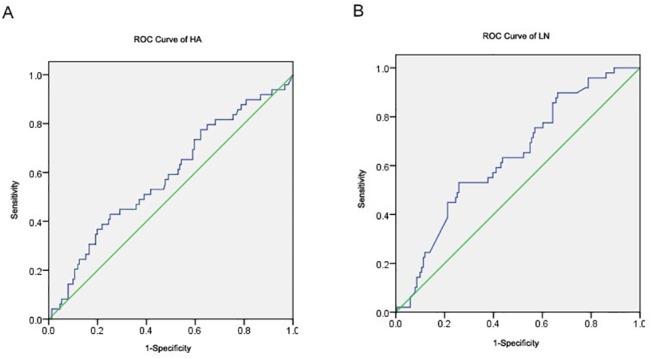
ROC curves of pre-operative HA and LN in evaluating postoperative liver dysfunction.A, ROC curve of HA; B, ROC curve of LN.